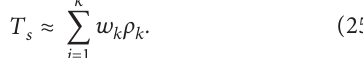
Figure 10: Particle distribution diagram at time t +